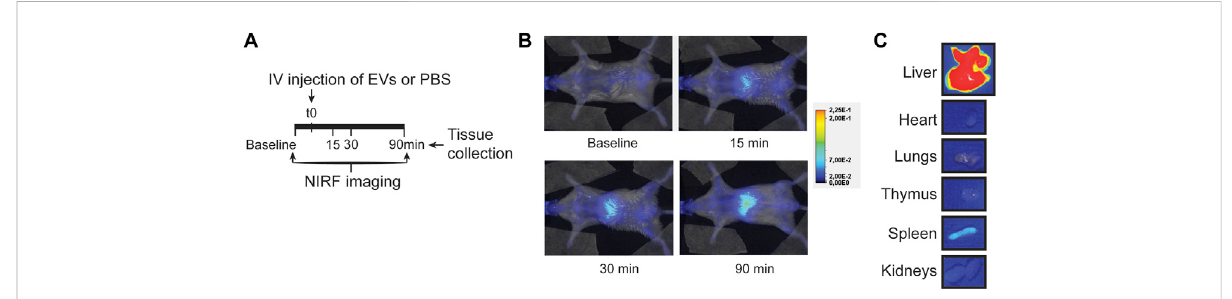
FIGURE 5 EV distribution in the mouse after intravenous injection. (A) Schematic overview of EV administration and NIRF imaging up to 90 min after tail vein injection. (B,C) Representative NIRF images taken (B) from the living animal at various time points after EV administration and (C) of individual organs collected after 90 min follow-up. Uncut images are included in Supplementary Figure